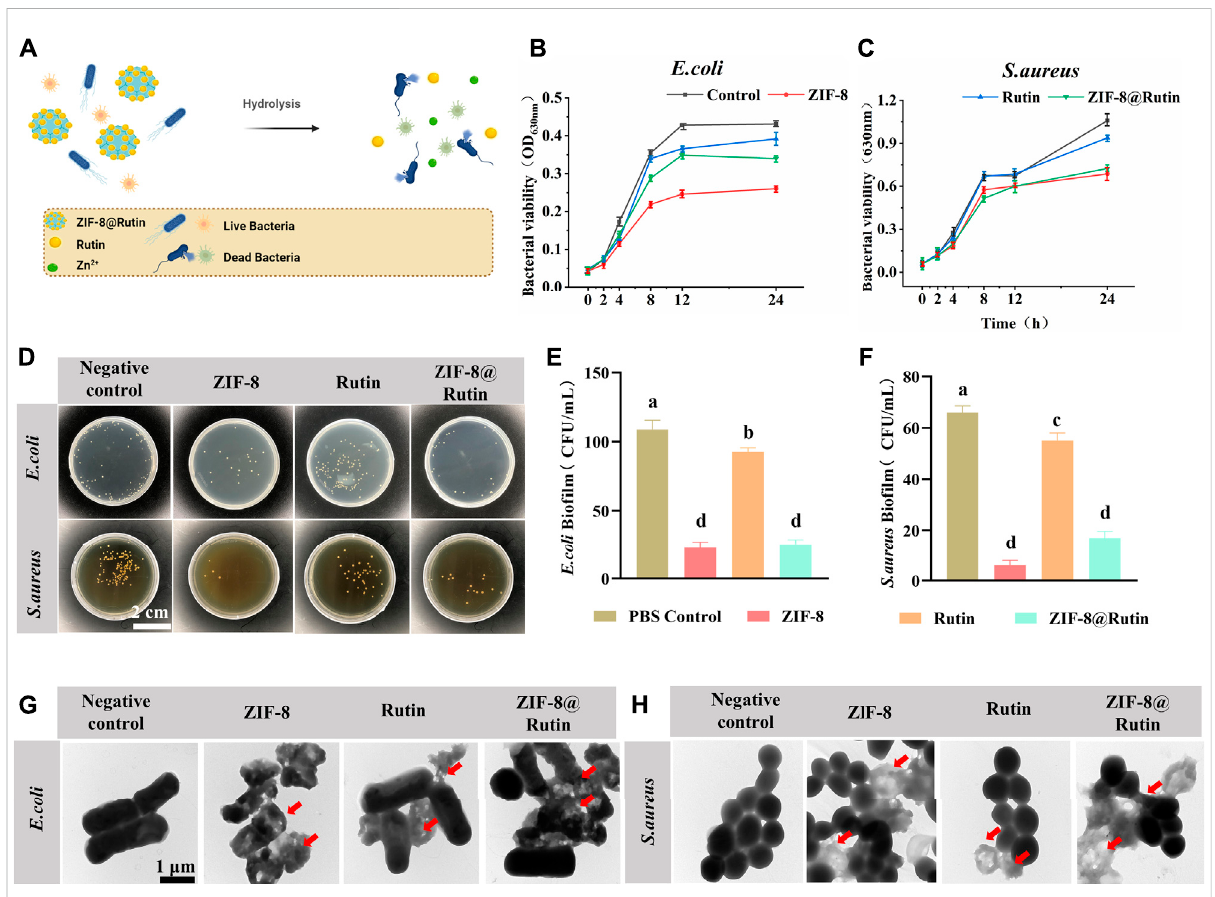
Antimicrobial properties of ZIF-8, Rutin and ZIF-8@Rutin nanocomposites. (A) Antimicrobial schematic of ZIF-8@Rutin NPs. (B,C) Inhibitory behaviorofZIF-8(30 μ g ml − 1 ),Rutin(40 μ g ml − 1 )andZIF-8@Rutin(40 μ g ml − 1 )onthemetabolicactivityof E.coli (B) and S.aureus (C) within24 h. (D) Representative pictures of E. coli and S. aureus colonies on agar plates after different groups of treatments. (E,F) Statistical graphs of CFU counts of single-species bio fi lms of E. coli (E) and S. aureus (F) . Representative TEM (G,H) images of E. coli and S. aureus . The morphology of the bacteria was altered at the red arrows. Dissimilar letters indicated values that were signi fi cantly different from each other group ( n = 6, p <